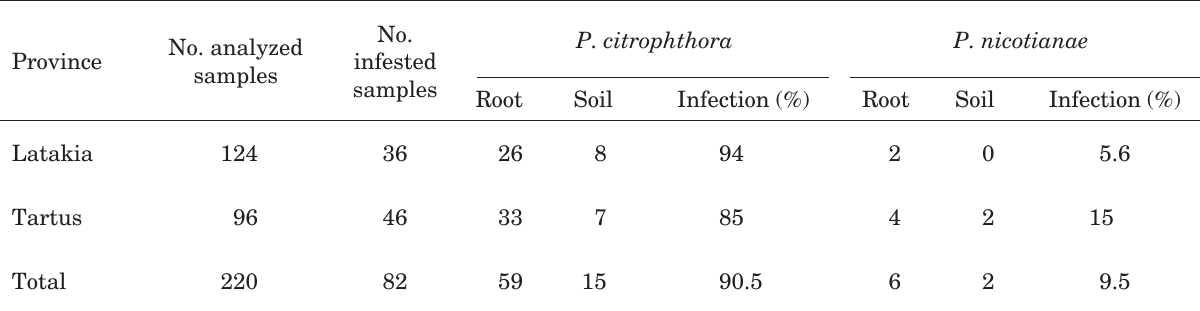
Table 1. Number and percentage of samples infested by Phytophthora citrophthora and P. nicotianae collected in Latakia and Tartus